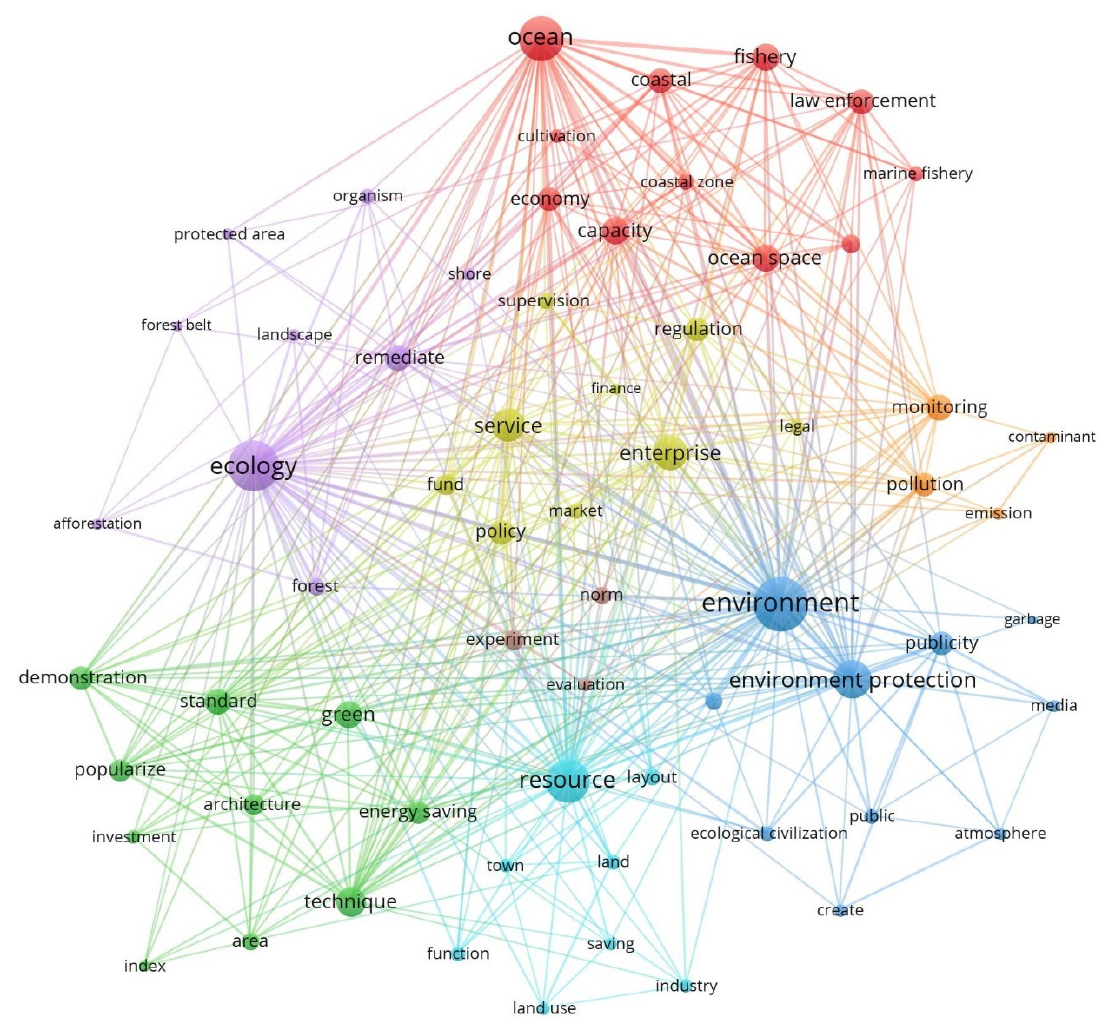
Figure 4. Co-word analysis and cluster analysis of keywords (2013–2017).